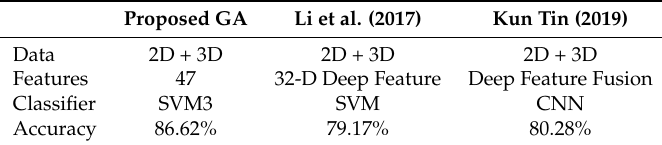
Table 19. Comparison on Bosphorus Dataset with deep features.